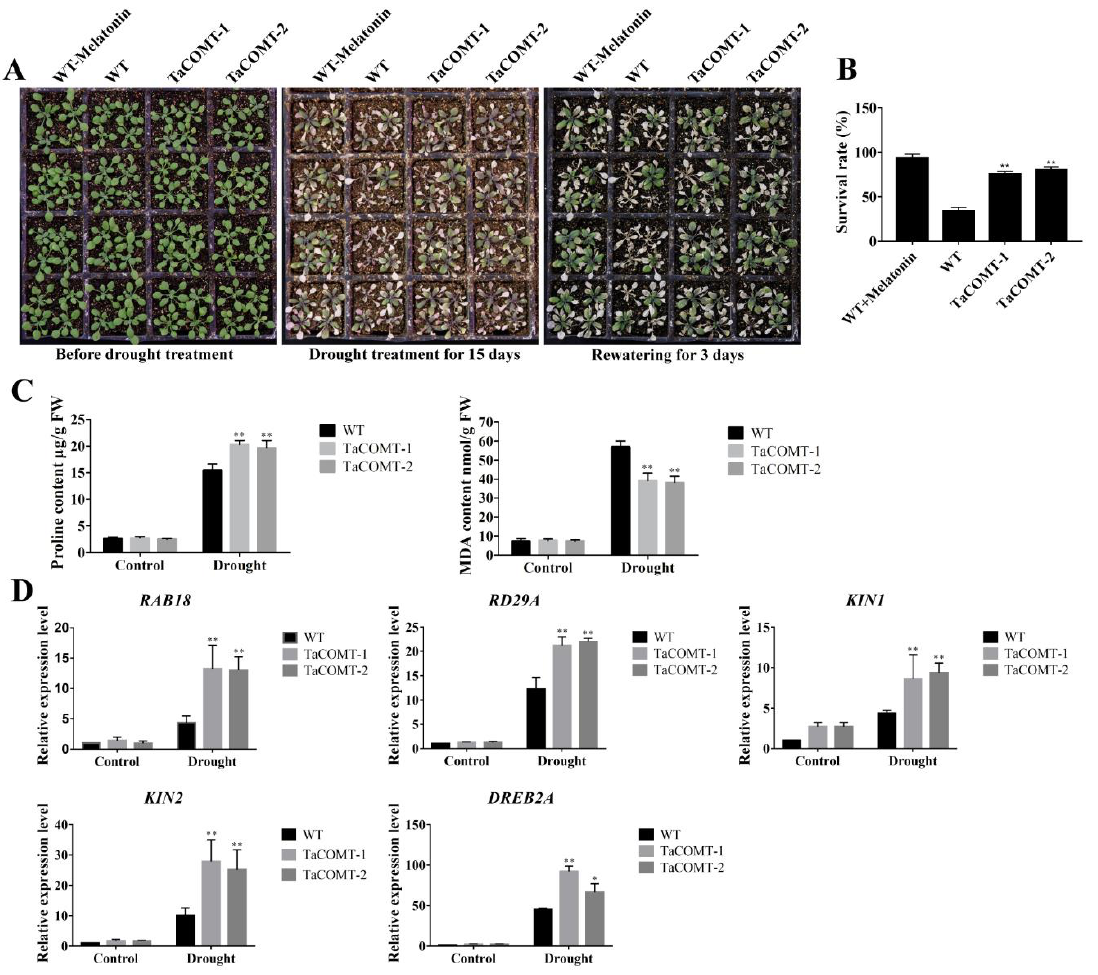
Figure 4. TaCOMT improved drought tolerance in transgenic plants. Three-week-old seedlings were treated without irrigation for 15 days ( A ). After three days of rehydration, the survival rates of WT and transgenic plants were counted ( B ). The contents of proline and malondialdehyde (MDA) of Arabidopsis seedlings treated with drought for 10 days ( C ). The two-week-old Arabidopsis seedlings were placed on filter paper to simulate drought for two hours, and then the transcription level of drought-responsive genes was analyzed ( D ). Expression of AtActin as a loading control. At least 25 seedlings per phenotype were counted. The data were shown as the means ± SDs ( n = 25) of three experiments. An ANOVA test identified significant differences (* p < 0.05, ** p < 0.01).